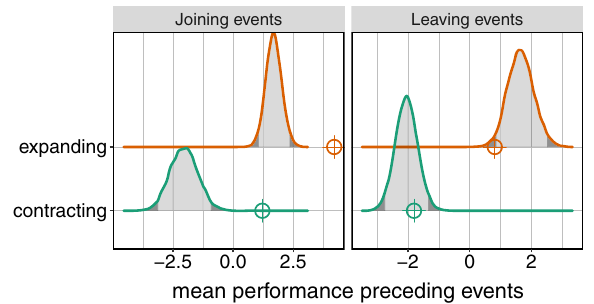
Fig. 6 Joining events are preceded by periods of high performance. The effects of performance (ant traf fi c fl ow over bridge relative to expected fl ow based on traf fi c over platforms) on joining and leaving events were analyzed with a resampling approach. Distributions (density plots) show the mean performance during the 10 s preceding events at randomized times, from 10,000 simulations, for joining events (left panel) and leaving events (right panel) during the expansion (orange) and contraction (green) phases (resampling analysis described in detail in Methods: Data Analysis). Dark gray shading in the tails of each distribution indicates the most extreme 5% of that distribution (below 2.5% and above 97.5%). The corresponding actual means from the experiments are shown as points (open circles with crosshairs). Performance preceding joining events is signi fi cantly and substantially higher than expected by chance. Performance preceding leaving events is marginally lower than expected during the expansion, and not different than expected during the contraction. Our conclusions for joining events are not sensitive to the time interval over which performance is measured (Supplementary Fig. 14 and Supplementary Note